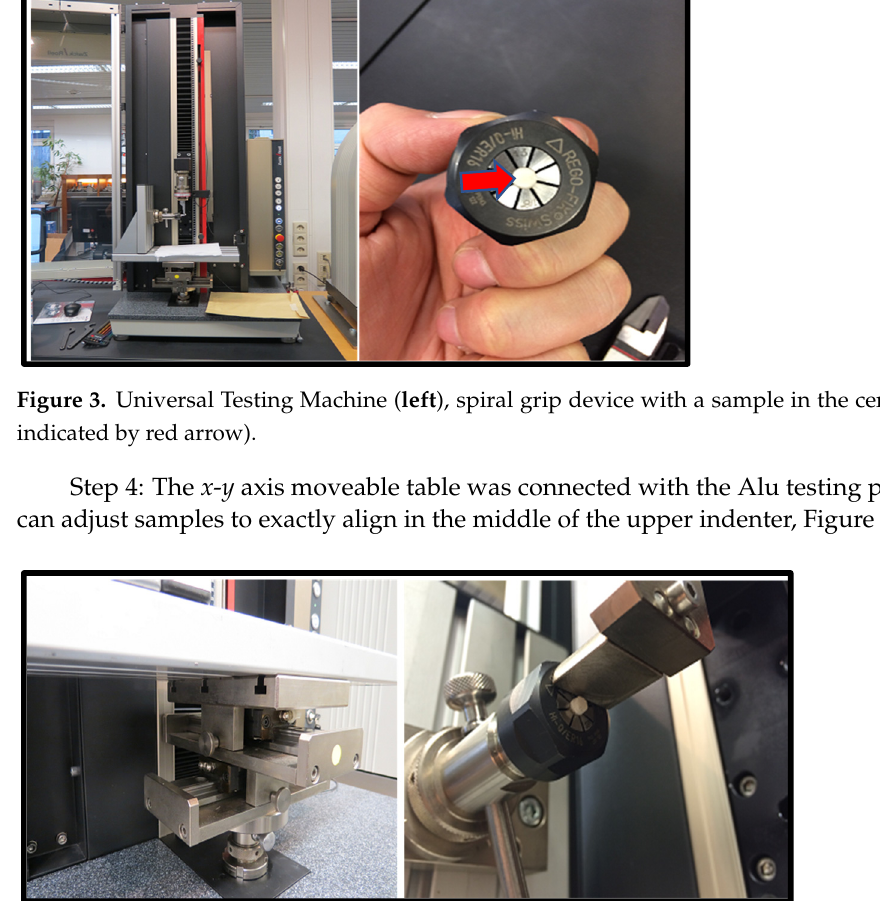
Figure 2. Calibration of the prepared restorative material samples.